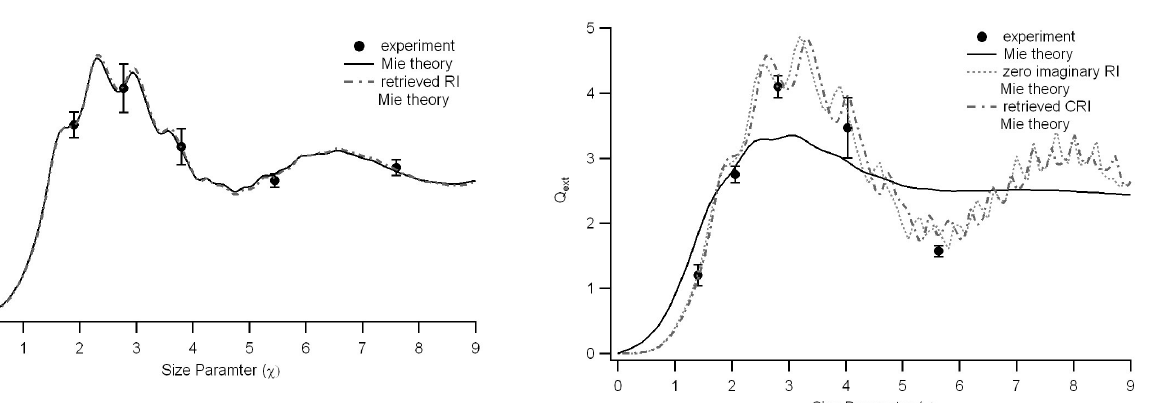
Figure 8. The experimentally measured Q ext versus size parameter for PSL at a wavelength of 248 nm are shown as solid black circles. The black line is the Mie theory calculation performed with a CRI from French et al. (2007) ( m = 1.826 + 0.059 i at λ =248 nm). The grey dot-dash line is the Mie theory calculation for the CRI retrieved from the experimental data ( m = 1.82 + 0.05 i ). The experimental extinction efficiency is reported for PSL diameters of 150 nm, 220 nm, 300 nm, 430 nm, and 600 nm (from left to right) and the reported error bars are 1 σ for repeat measurements.